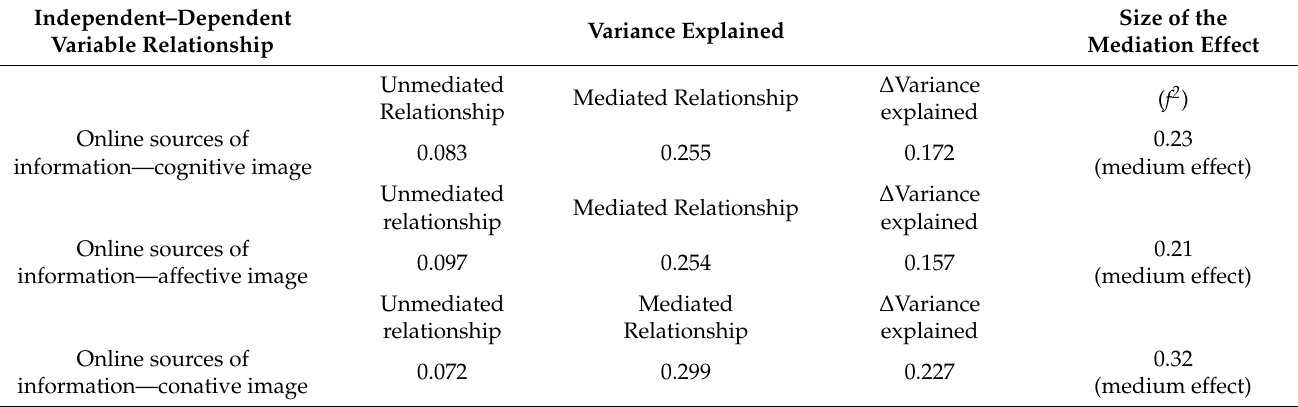
Table 8. Mediation effect size of motivation to